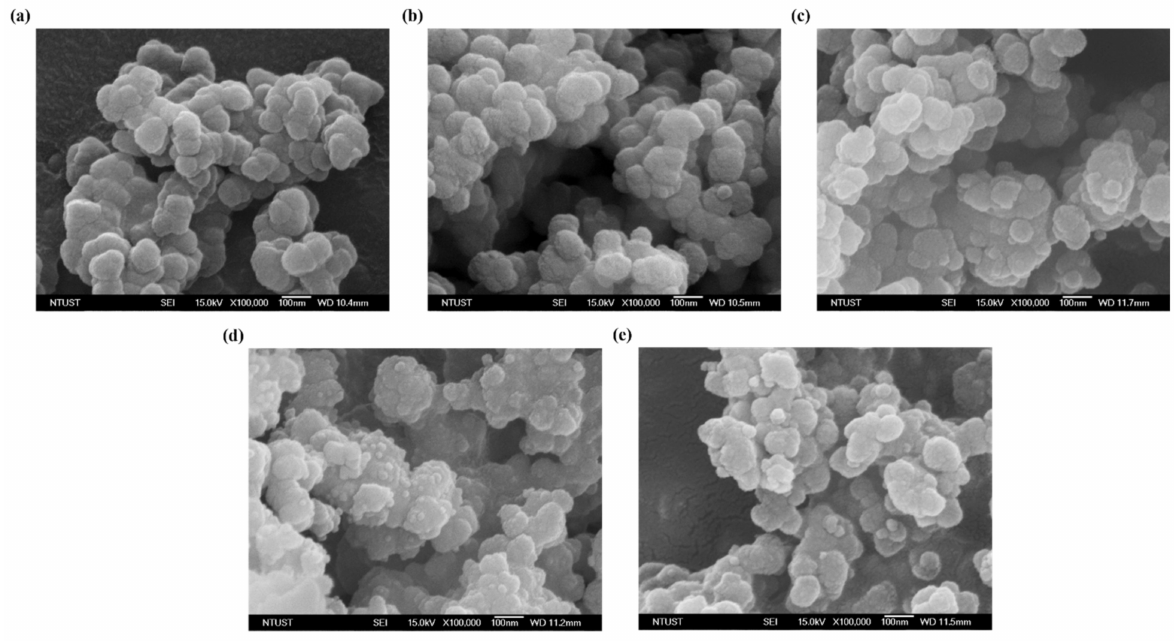
Figure 2. SEM images of ( a ) Zr-MOF, ( b ) MDC-500, ( c ) MDC-700, ( d ) MDC-900, and ( e )